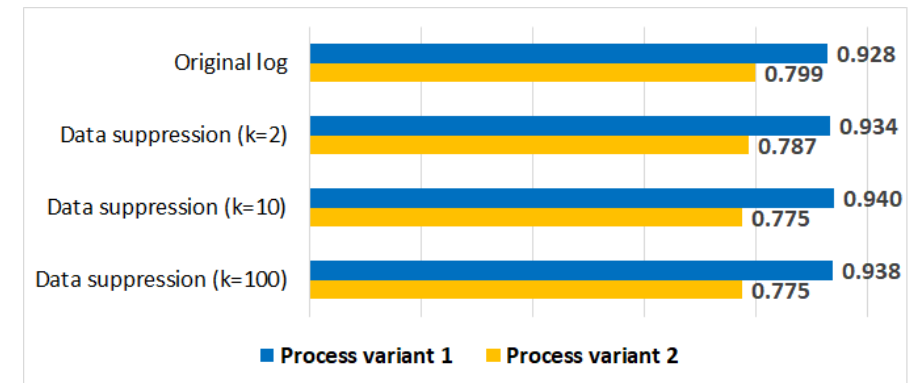
Figure 10. The impact of data suppression on the average trace fitness values for process variant 1 and process variant